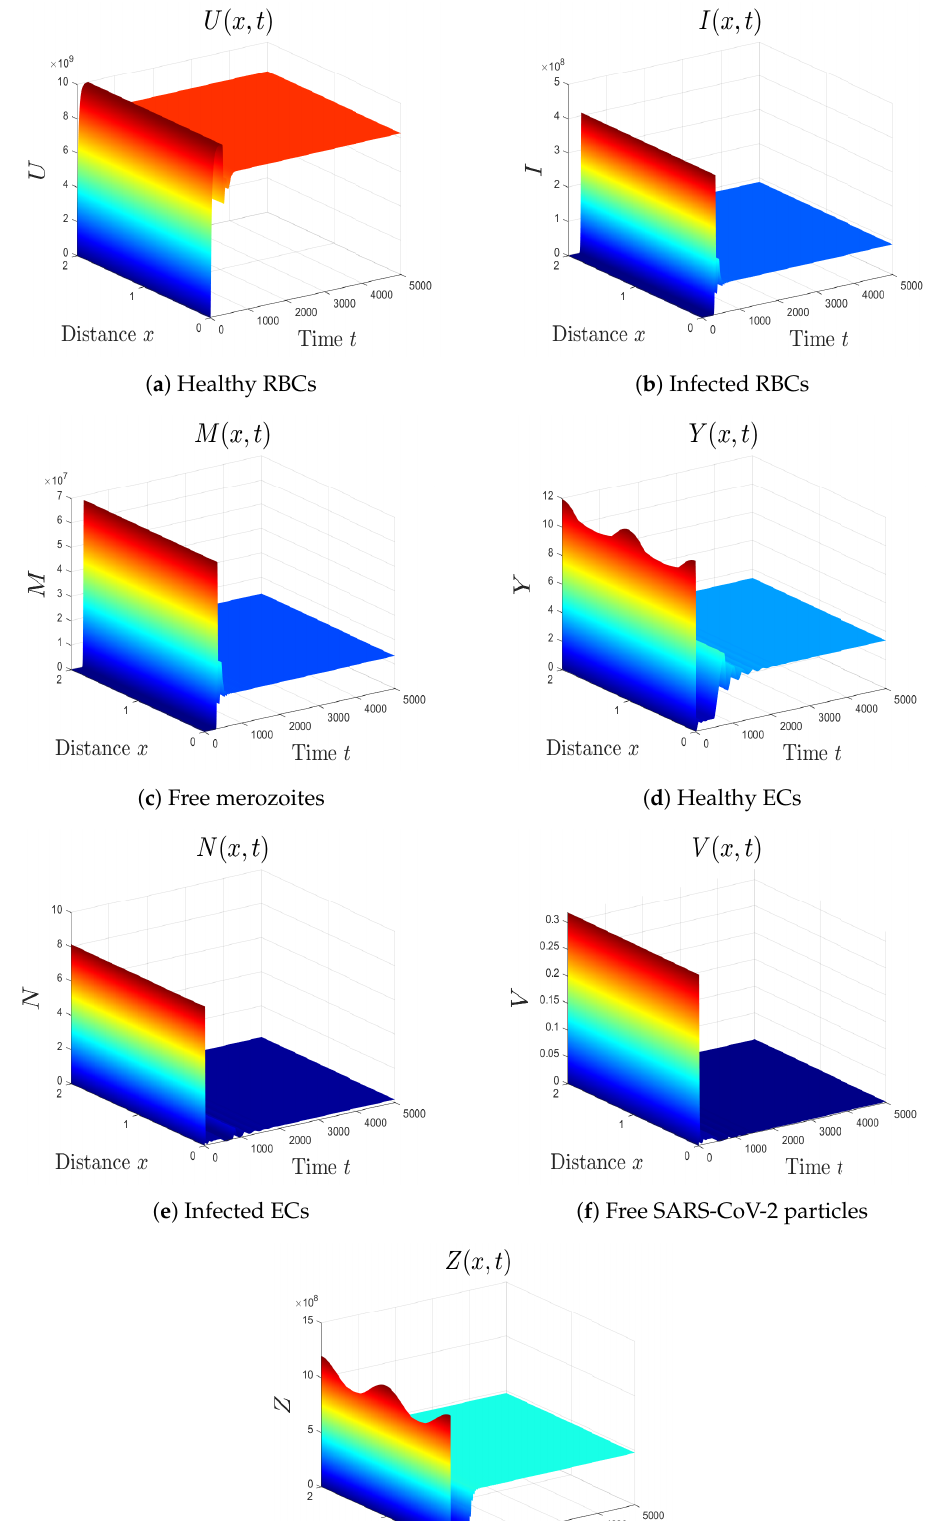
Figure 7. Simulation of system (1) for ( β m , β v , p 1 , p 2 , d 7 ) = ( 4 × 10 − 10 ,3.9,3 × 10 − 8 ,0.5,0.4 ) . The equi- librium E 6 = ( 8.244 × 10 9 ,8.78 × 10 7 ,1.33 × 10 7 ,3.36,0.17,0.0015,4.76 × 10 8 ) is